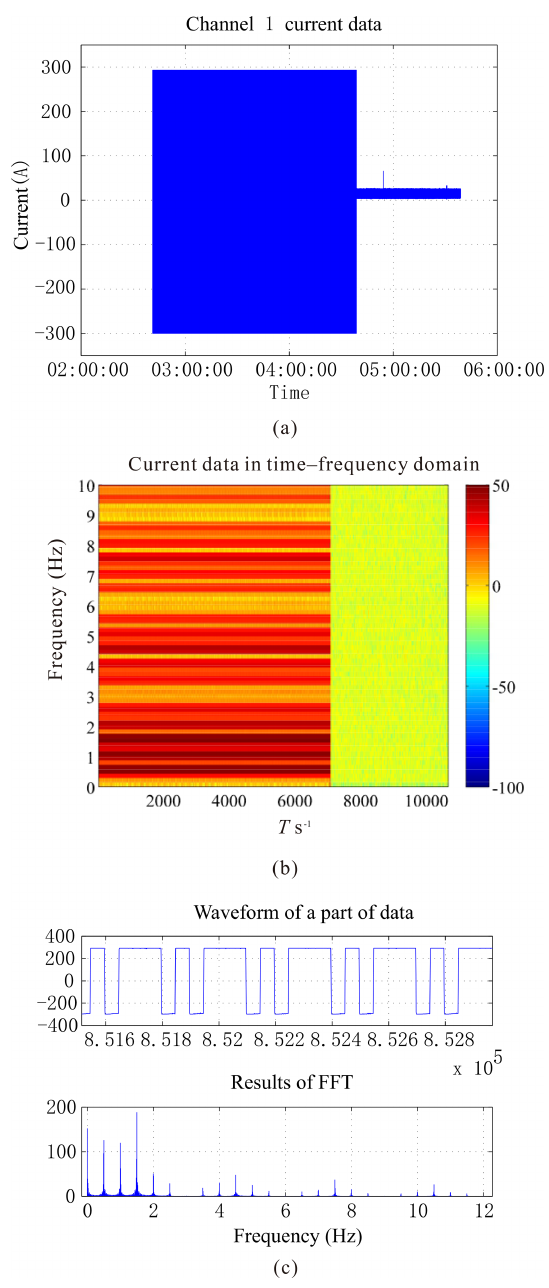
Figure 1. (a) Transmitting-current data, (b) time–frequency spec- trum diagram, and (c) waveform diagram intercepted during work in the South China sea in 2016, with a sampling rate of 150Hz.